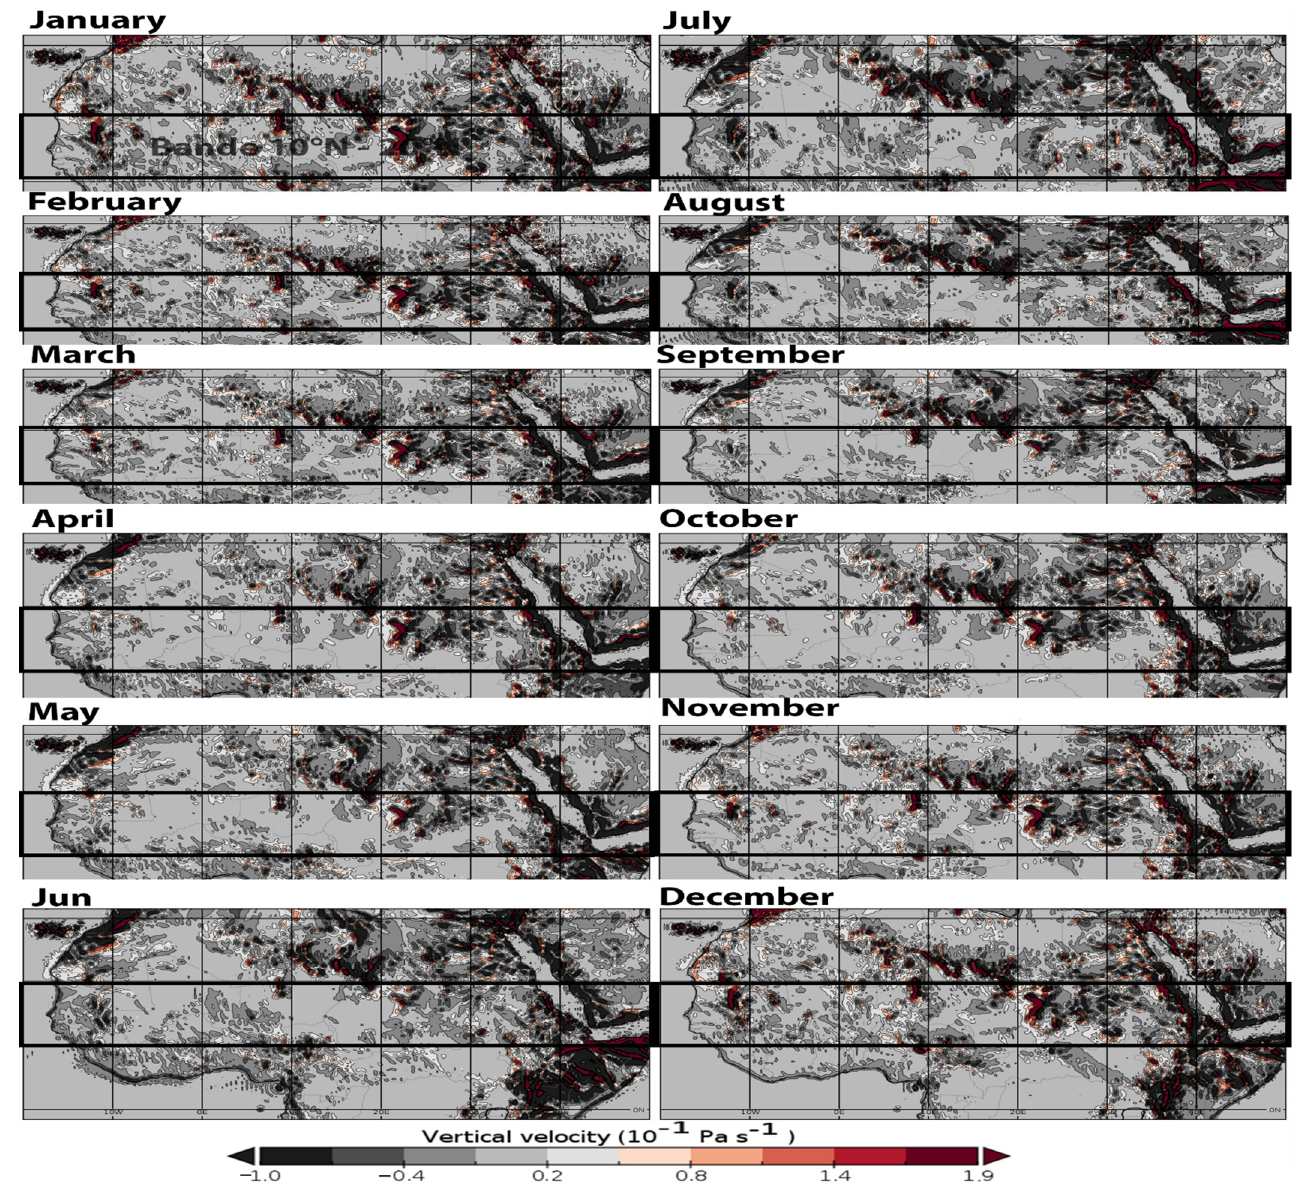
Figure 4. Climatology in monthly average vertical velocity (4D-Var ERA5) in Pa s − 1 from 1979 to 2008 with a resolution of 0.5 × 0.5 degrees. Data from the ERA5 platform.